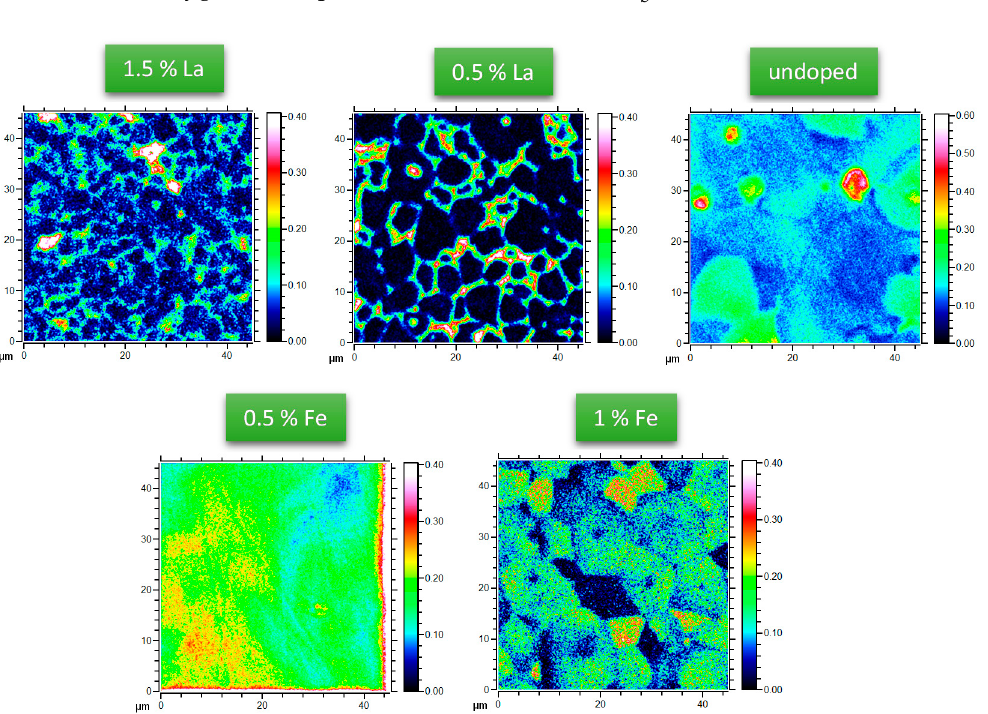
Figure 2. Tracer distribution images of differently doped PZT after diffusion at 715 °C with clear indication of fast grain boundary diffusion in the donor doped samples; 18 O tracer fractions are shown.